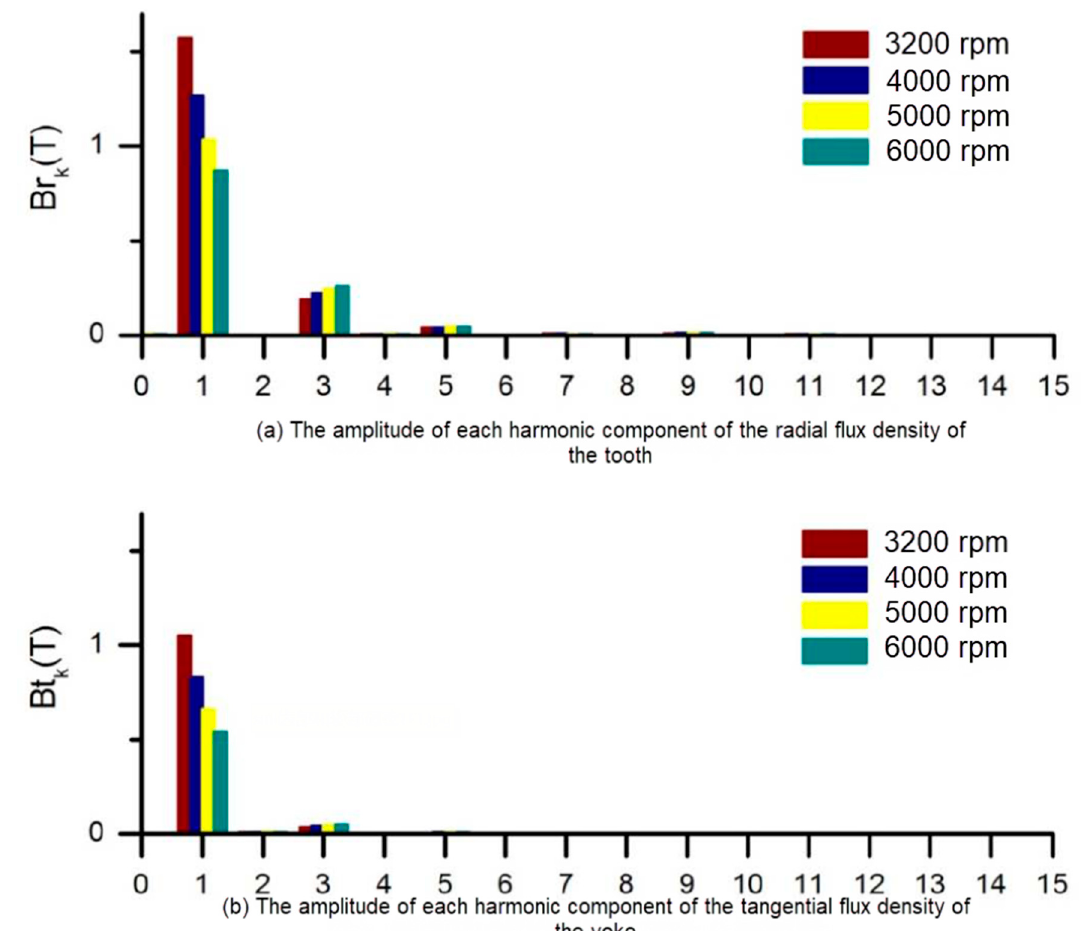
Figure 10. The amplitude of each harmonic component of the radial flux density of the tooth and the tangential flux density of the yoke.